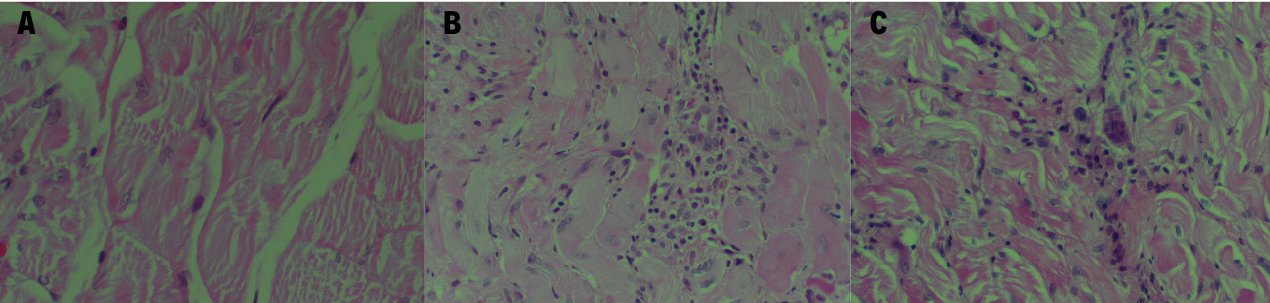
FIGURE 2 - Light microscopy of muscle tissues of experimental groups for H&E staining. (A) In control rats, normal muscle structure was seen. (B) After I/R, severe muscle damage was detected. (C) Therapy of UD-ameliorated muscle tissue injury. (H&E, scale bar, 50